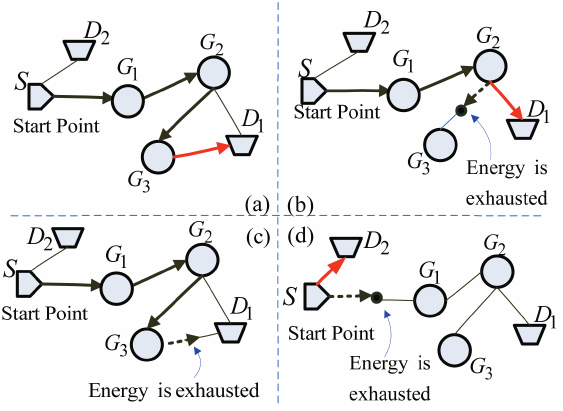
Fig. 3. Four cases of task